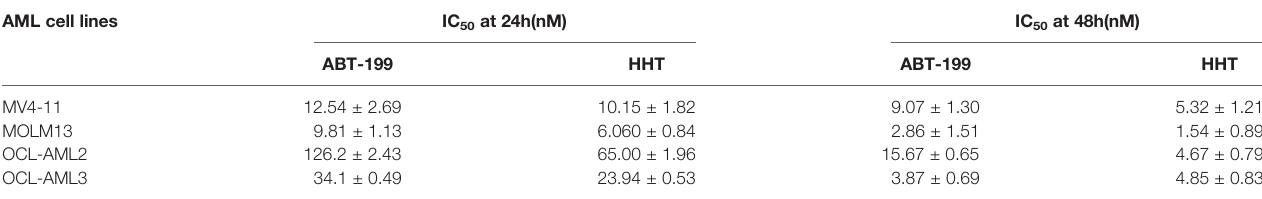
IC50: Half maximal inhibitory concentration.